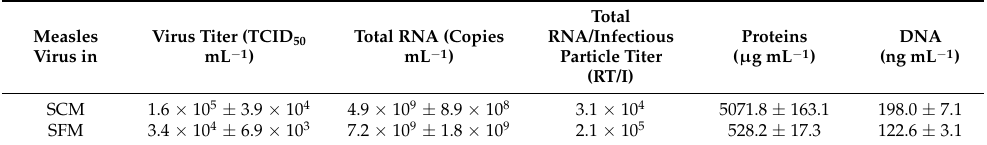
Table 1. Characterization of MV suspensions in serum-containing medium (SCM) or serum-free medium (SFM). Data are means ± SEM (n = 5)